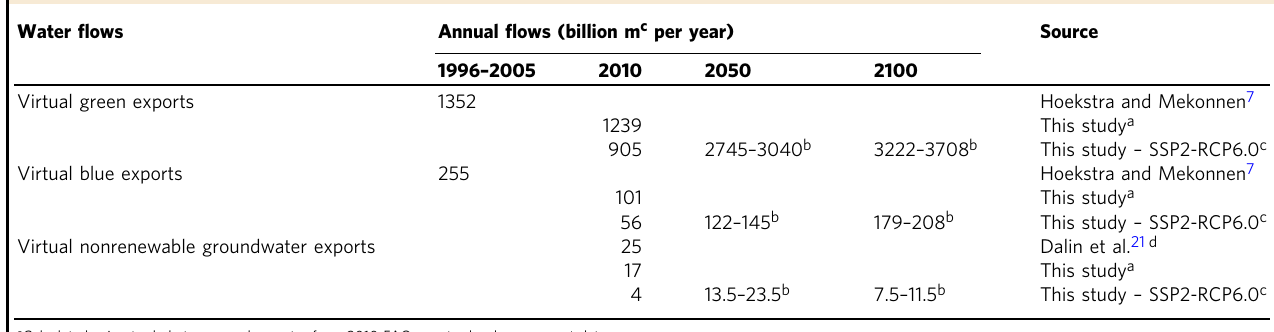
Table 1 Global physical water fl ows with comparisons to previous historical studies 7,21 .